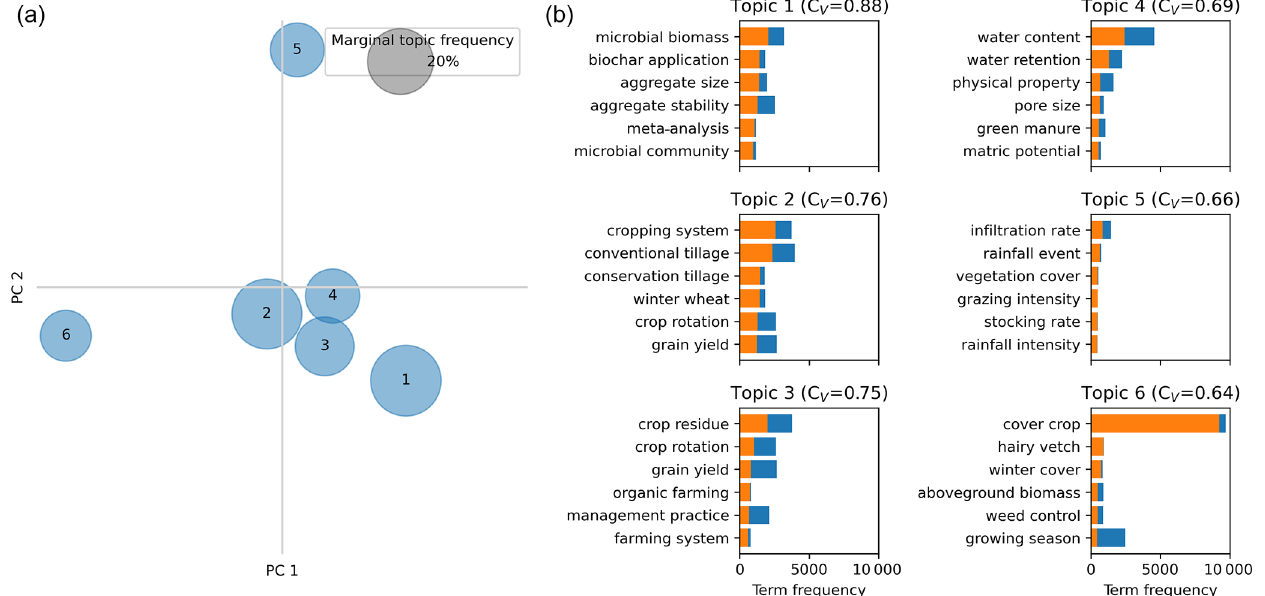
Figure 5. (a) Map of topics according to the first two principal components after dimension reduction. (b) For each topic, the six more relevant bigrams inside the topic are shown. The orange bars represents the term frequency inside the topic, while the length of the full bars (orange + blue) represent the term frequency in the entire corpus. The gray circle represents the size of a topic that contains 20% of the documents of the corpus. Table 3. Scores of the rule-based extraction methods. n is the number of items to be extracted. It varies as several coordinates can be provided